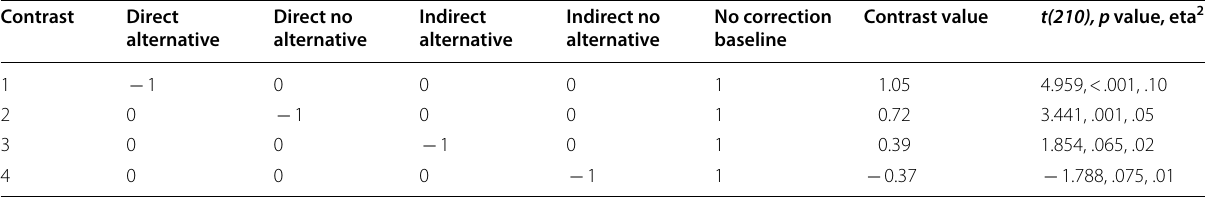
One-way ANOVA, F (4, 210)